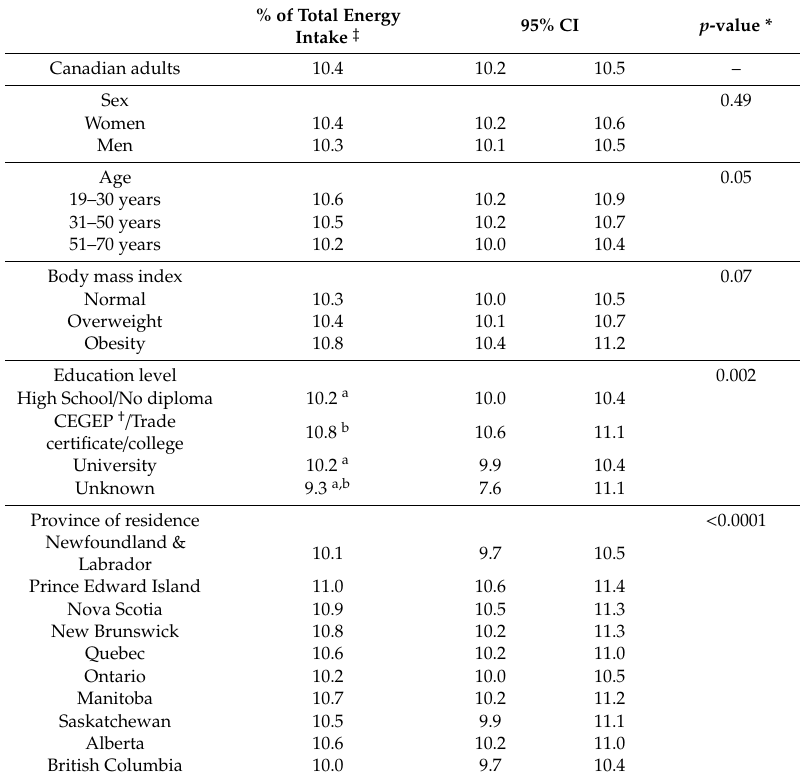
Table 1. Saturated fatty acids (SFA) consumption in all Canadian adults and according to sex, age group, education level, body mass index, and province of